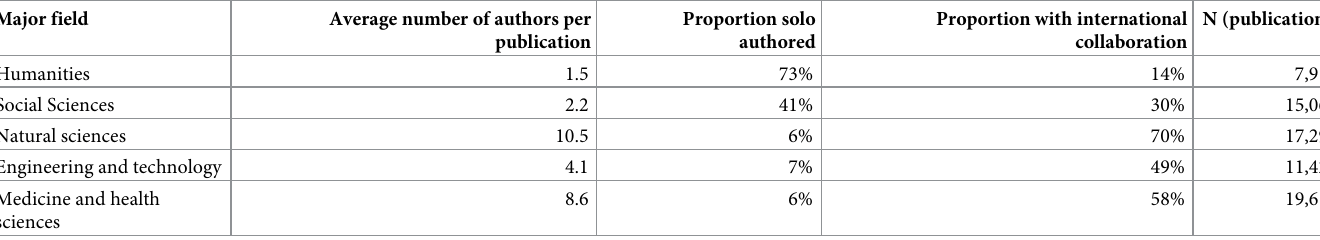
Table 3. Overview of basic co-authorship measures across major fields (2015–2017